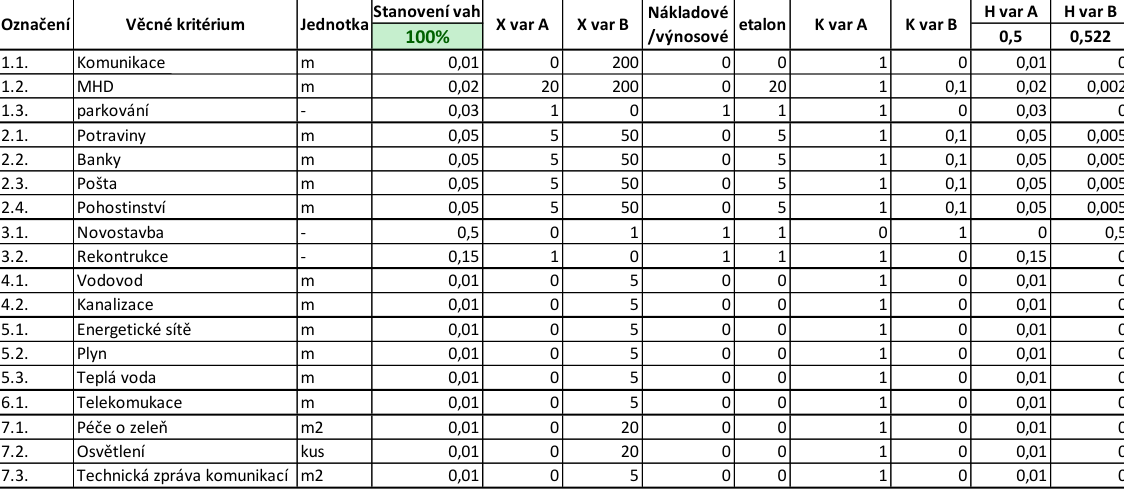
Tab.4: Výpočet bazické varianty z pohledu investora. zdroj: vlastní